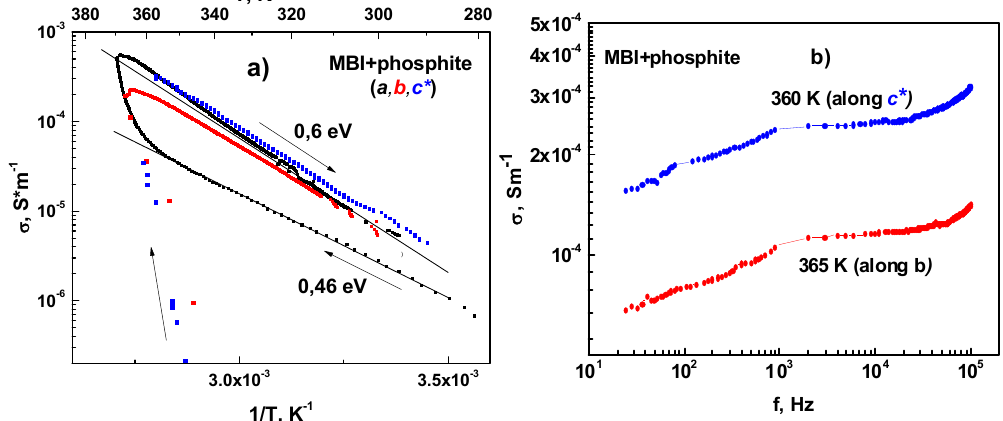
Figure 11. ( a ) Specific conductivity of MBI-phosphite for a-, b-, and c*-axes in semilogarithmic scale as a function of inversed temperature. Lines correspond to Arrhenius law approximation for heating and cooling. ( b ) Frequency dependence of conductivity (log-log plot) along the a- and b-axes at high temperature in MBI-phosphite.